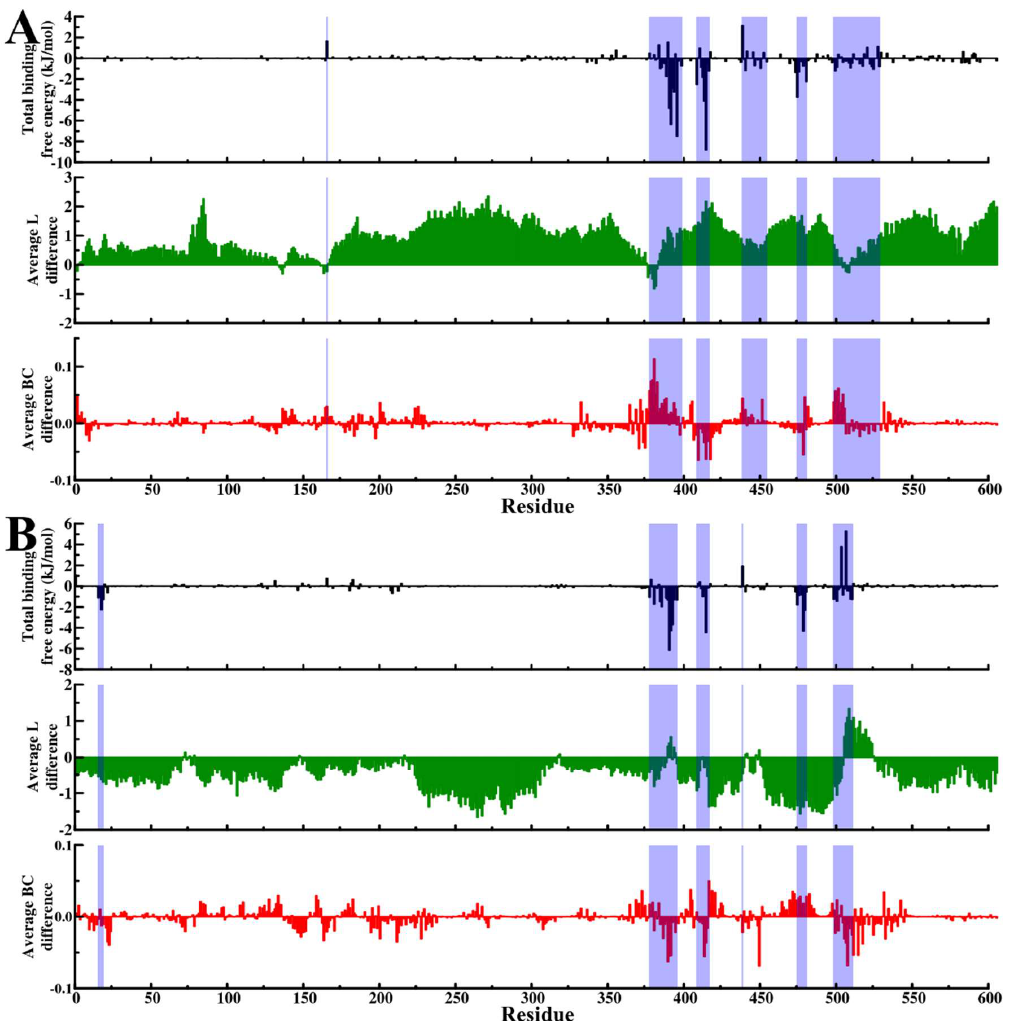
Figure 7. Effects of ligand binding on residue accessibility and centrality. Graphical mapping of structural regions making significant contribution to total binding free energy (shaded blue) onto plots of average L difference (green) and average BC difference (red). Change in residue accessibility (average L difference) and residue centrality (average BC difference) were obtained from calculations of SANC00132-free less SANC00132-bound values. For each metric, per residue means across both sets (set1 and set2) of experiments was initially calculated. (A) Hsp72, (B) Hsc70. Table 3. ( A and B ) Tabulated summary of residues possessing high average BC indices across all ligand-free and ligand-bound trajectories of each protein. Identified residues and respective positions were mapped within the primary sequence. Residues are underlined while positions and numberings are indicated above the residues. Numbering is based on E. coli DnaK template sequence (UniProtKB ID: P0A6Y8). Continuous stretches of residue positions are indicated by colon punctuations. Residues highlighted in red represent residues agreeing with PRS results on E. coli DnaK [18]. Residues existing within the ligand binding site are shown in bold. Corresponding residue numbering from complete sequences of respective proteins are shown in Table S9A,B.